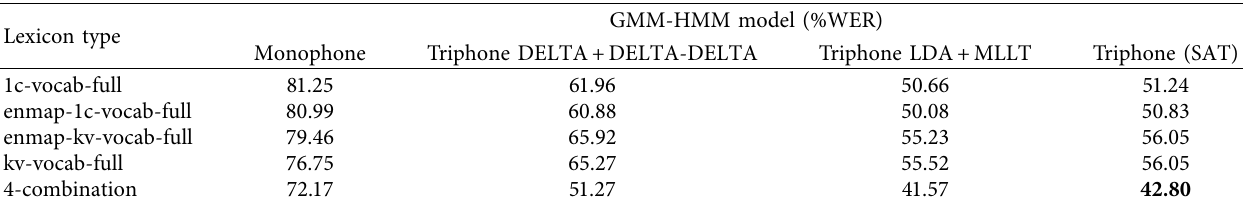
Table 14: The performance of the models using 46,550 validated utterances, for the four-combination lexicon type. Lexicon